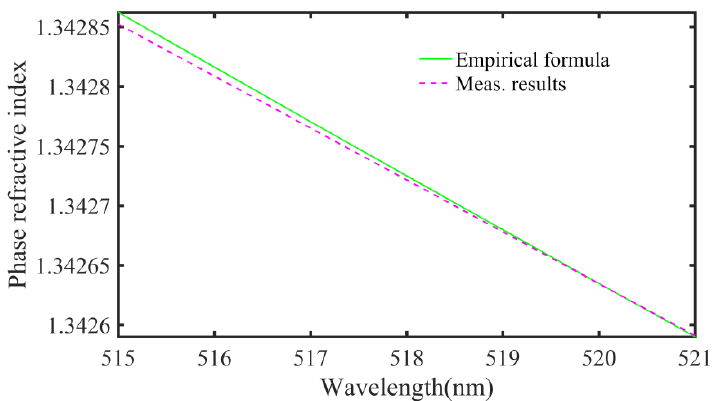
Figure 8. Results of the phase refractive index measurement; pink dashed line: result of our method; green solid line: result of the empirical formula.